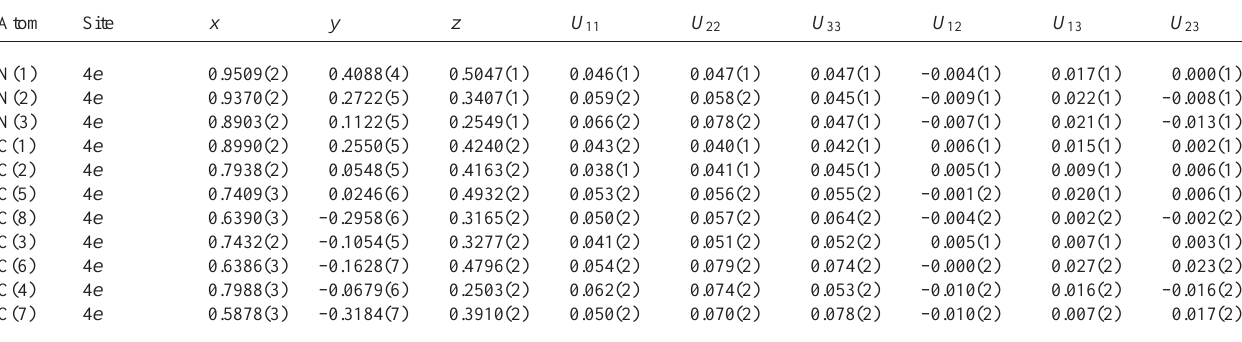
Table 3. Atomic coordinates and displacement parameters (in Å 2 )